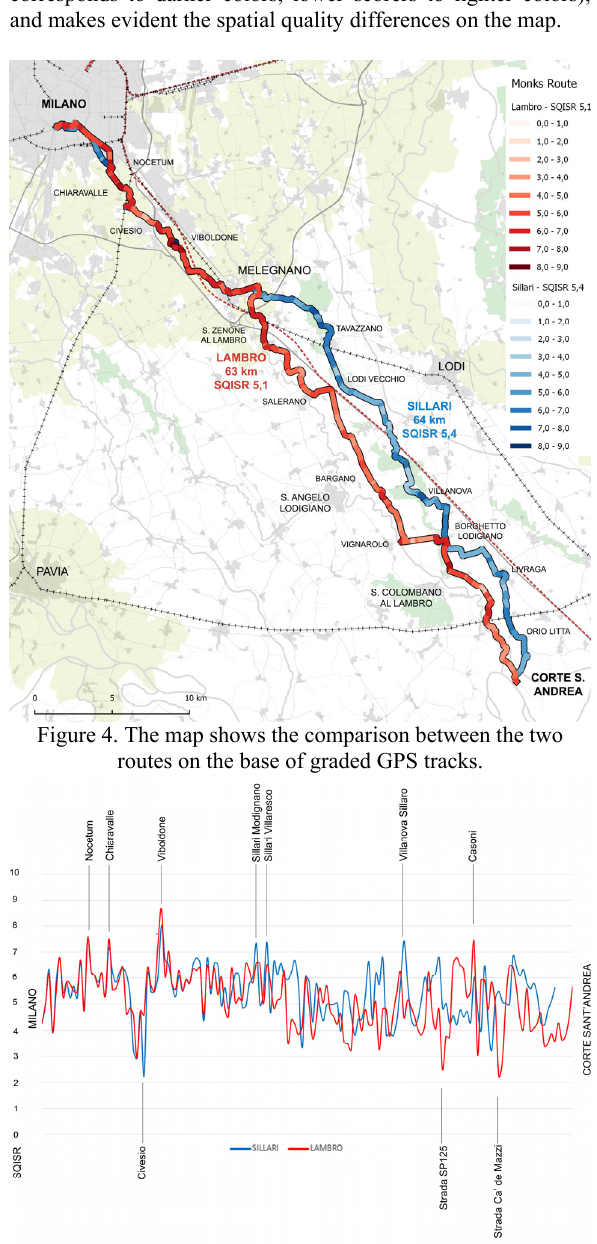
Figure 5. Graph with the comparison of the spatial quality trends of the selected routes. Best and the worst points along the routes have been highlighted.